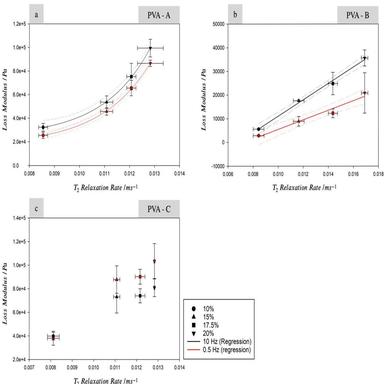
Loss Modulus plotted against MR T2 Relaxation Rate for 0.5 Hz (red), and 10 Hz (black) for PVA-A (a), PVA-B (b), and PVA-C (c). Error bars show 95% confidence (n = 6). Regression lines for 0.5 Hz (red), and 10 Hz (black) are also given; dashed lines show 95% confidence intervals for regression. (For interpretation of the references to colour in this figure legend, the reader is referred to the web version of this article.)